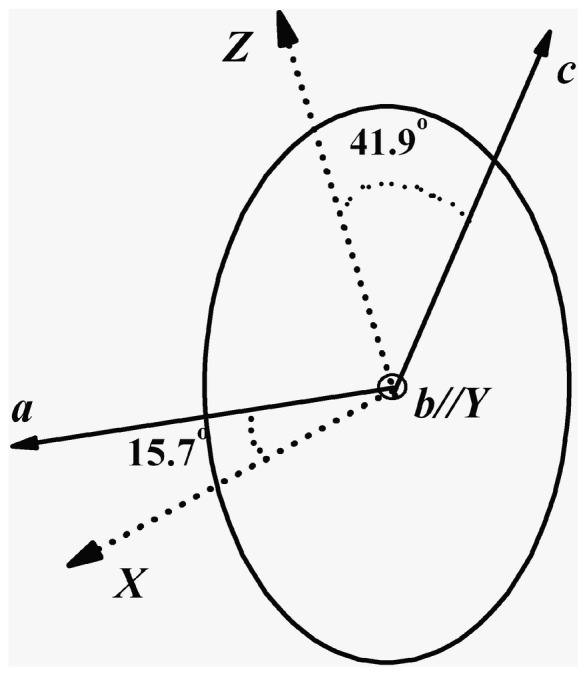
Orientation of principal axes X, Y, Z to the a-,b- and c-axis for Yb3+:KBaGd(MoO4)3 crystal.